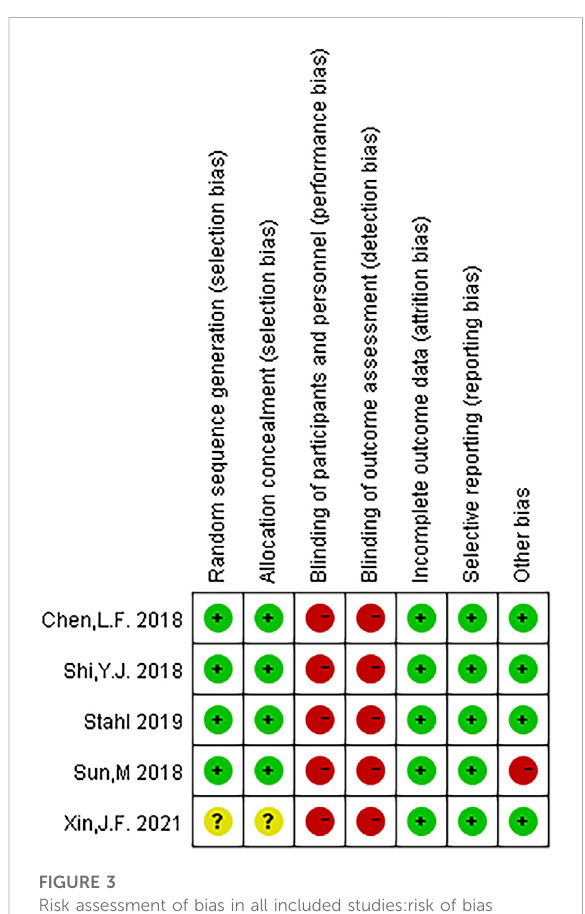
FIGURE 3 Risk assessment of bias in all included studies:risk of bias summary.